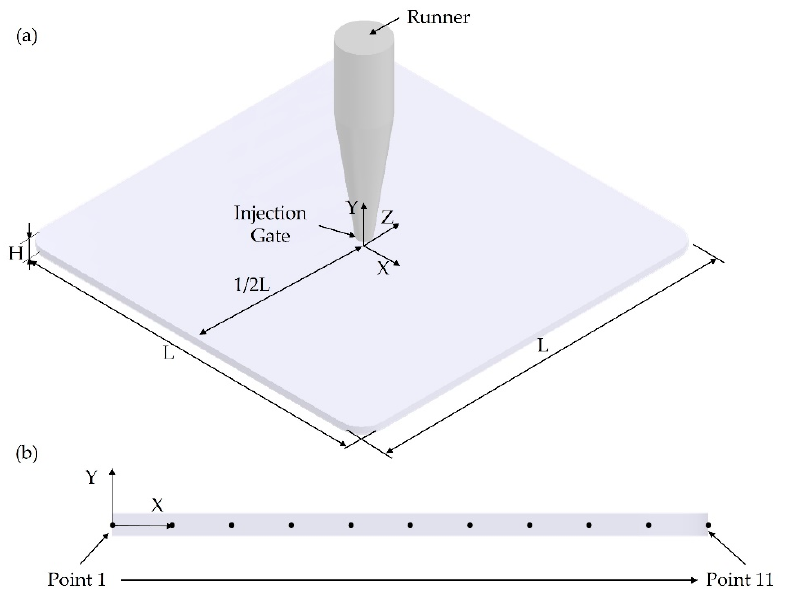
Figure 2. ( a ) The model dimensions and injection gate location and ( b ) selected cross-section area and points considered for analysis. The distance between two consecutive points is 8.25 mm.